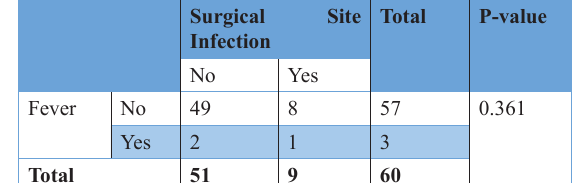
Table 3. Correlation between surgical site infection (SSI) and